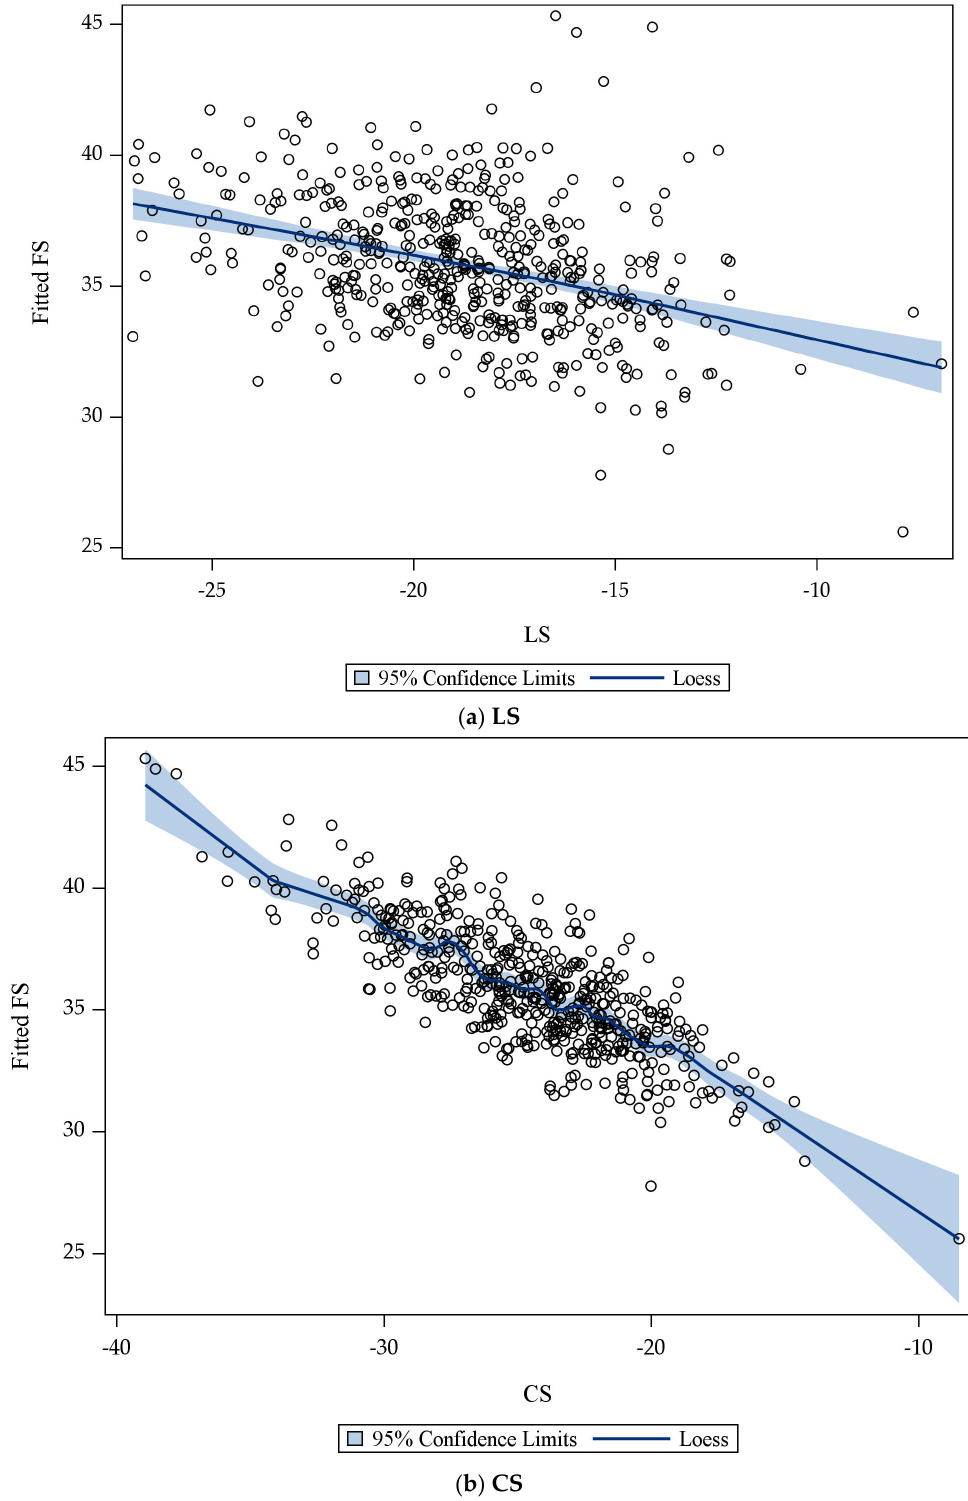
Figure 4. ( a , b ). Estimated Fractional Shortening Using Longitudinal or Circumferential Strain. Fitted fractional shortening (FS) values (circles) across longitudinal strain (LS) values ( a ) and circumferential strain (CS) values ( b ). Loess-smoothed curve of the fitted FS values, along with the corresponding 95% confidence band, is also